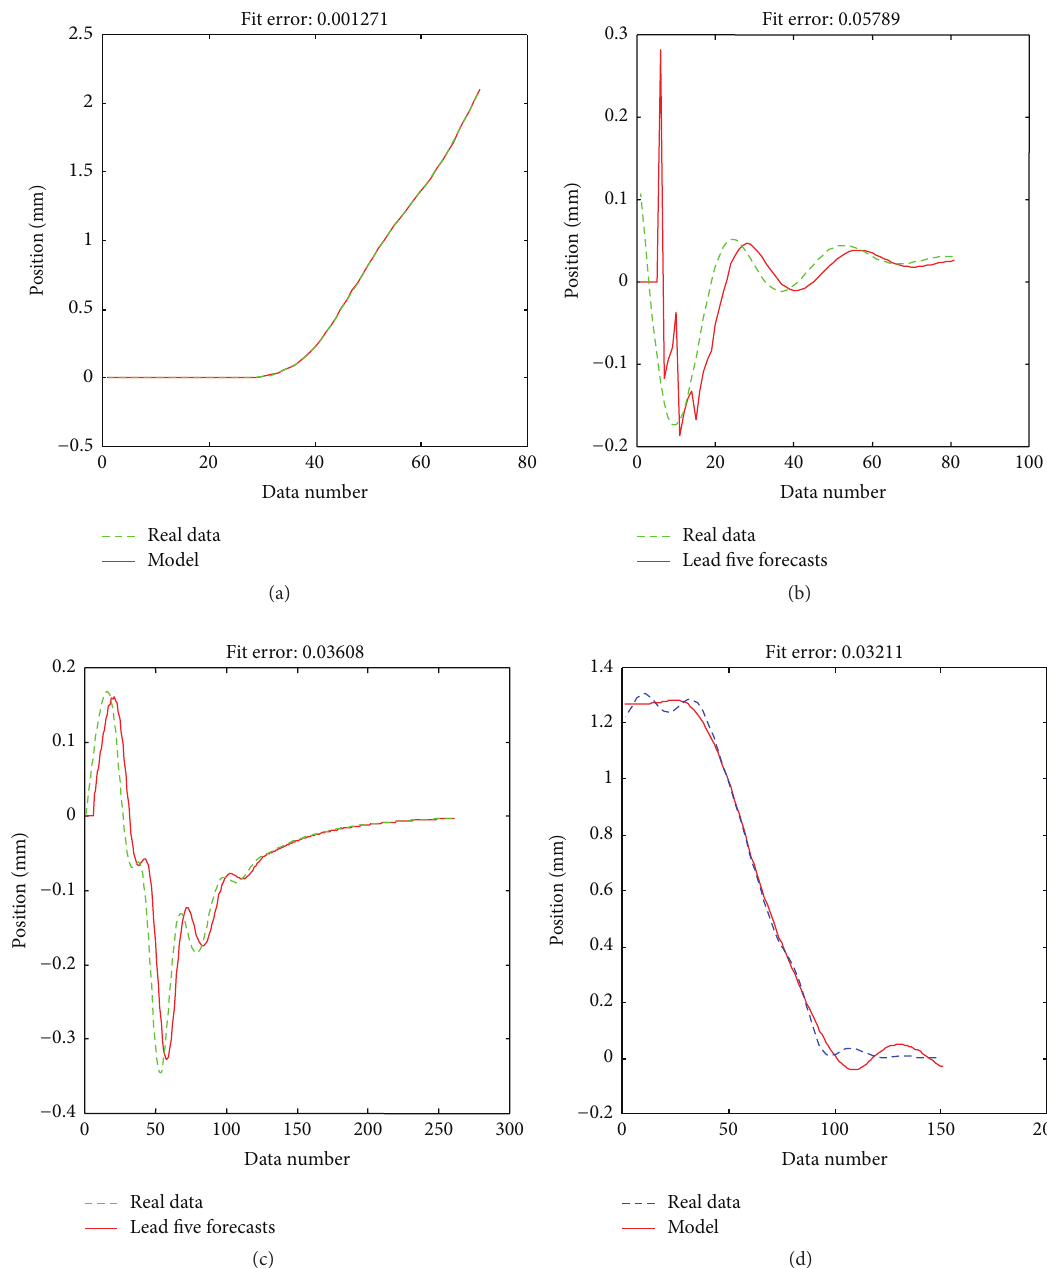
Figure 15: Model verification for the subsystem D for 240 rpm operation speed: (a) section 1 , (b) section 2 , (c) section 3 , and (d) section 4 .